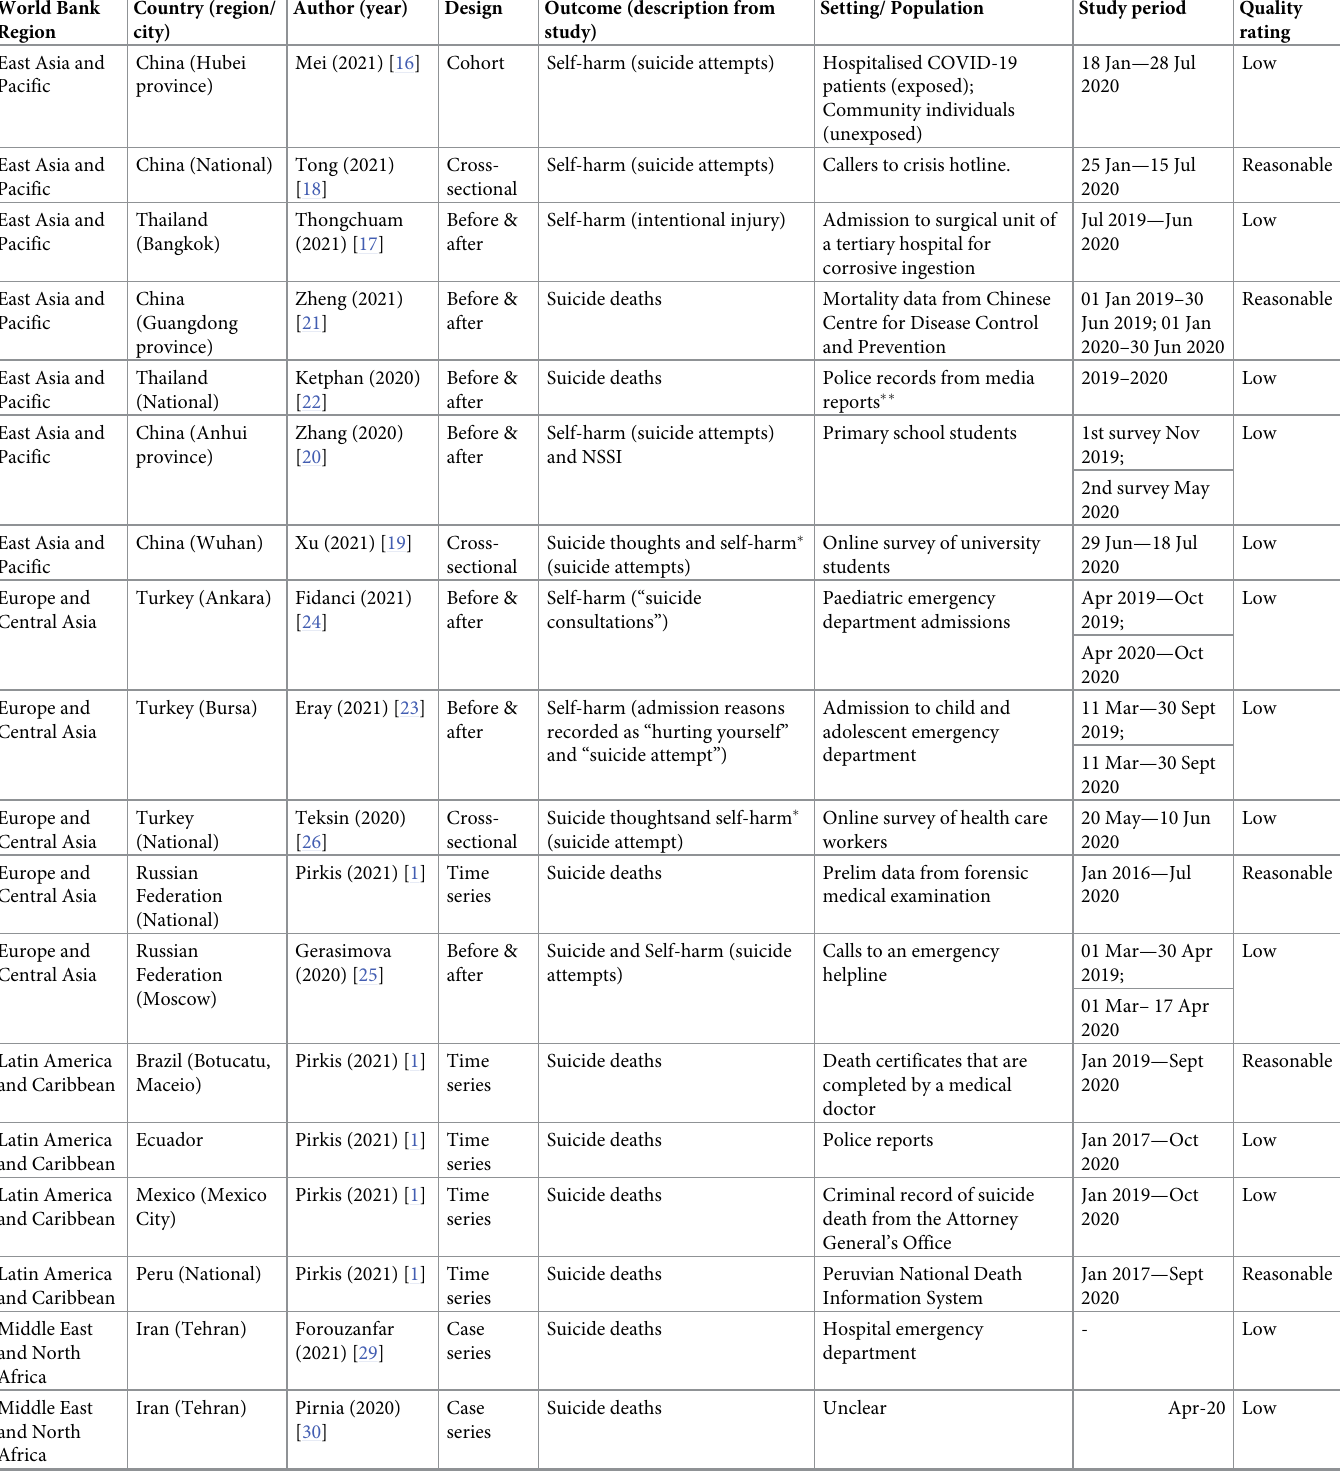
Table 2. Summary of included